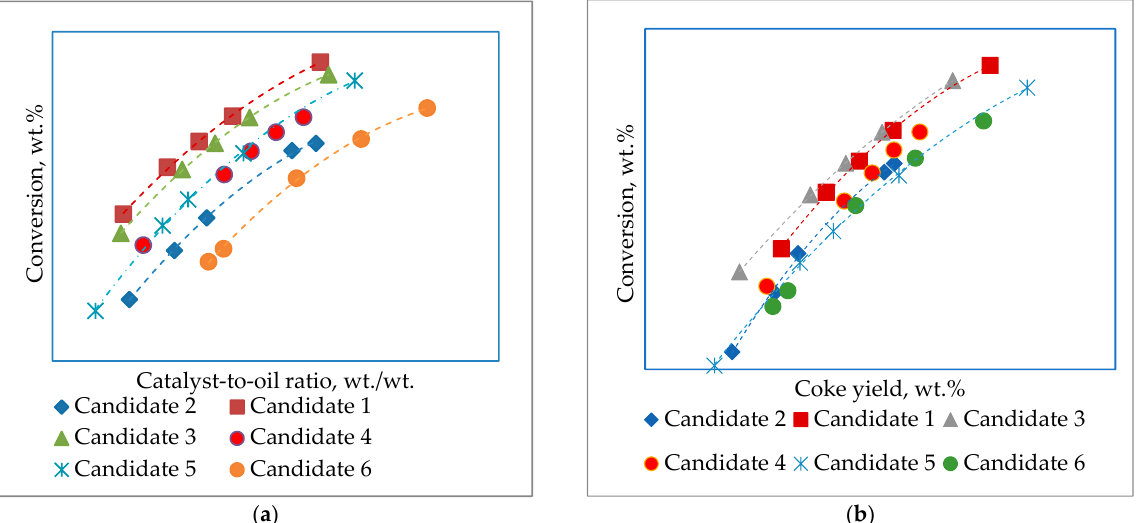
Figure 1. Laboratory tests with six catalyst candidates to select the most active ( a ) and coke selective ( b ) catalyst to employ in the revamped FCC unit.